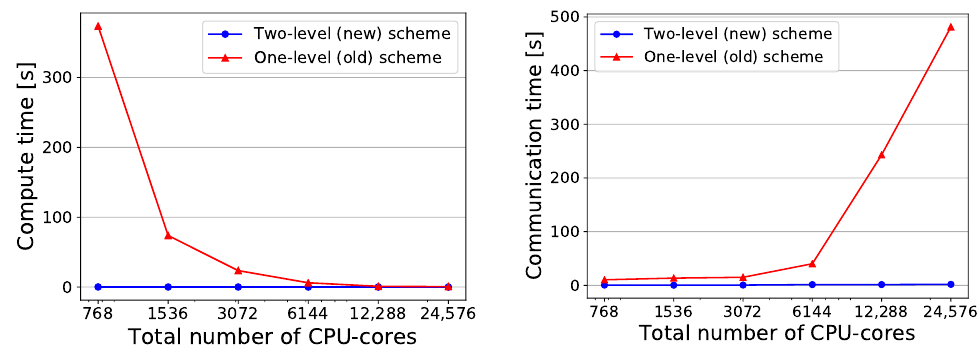
Figure 8. Strong scalability measurements: Comparison of run times for mapping computation ( left ) and mesh communication ( right ) between between the two-level and the one-level scheme. The mesh M4 is used for conducting the